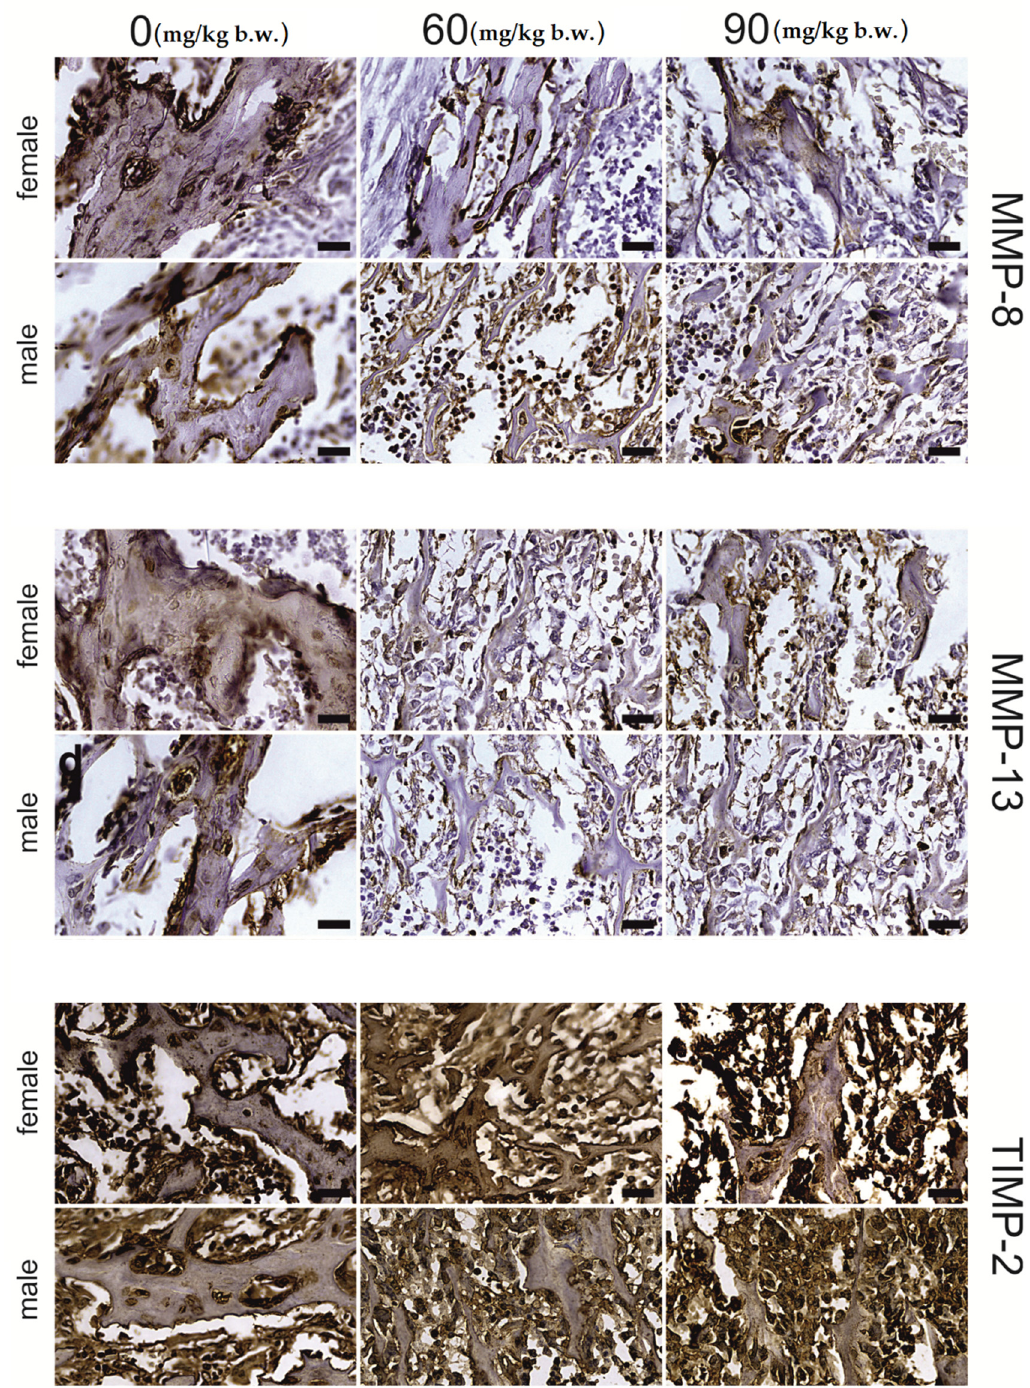
Figure 5. Representative images of the immunohistochemical reactions for MMP-8, MMP-13 and TIMP-2 from the trabecular bone of newborn rats (female and male) exposed prenatally to 0, 60 and 90 mg/kg b.w. of fumonisins. All the scale bars represent 40 µ m. Sample pictures of the trabecular bone with signed trabeculae, osteocytes and marrow space are presented in the Supplementary Materials, Figure S2.